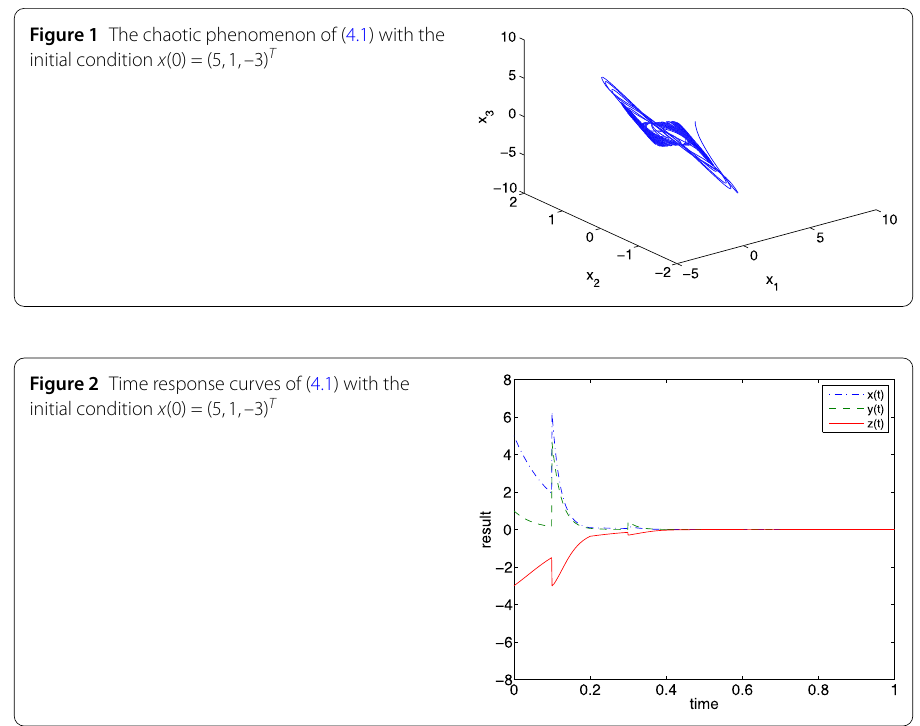
Figure 2 Time response curves of (4.1) with the initial condition x (0) = (5,1,–3) T